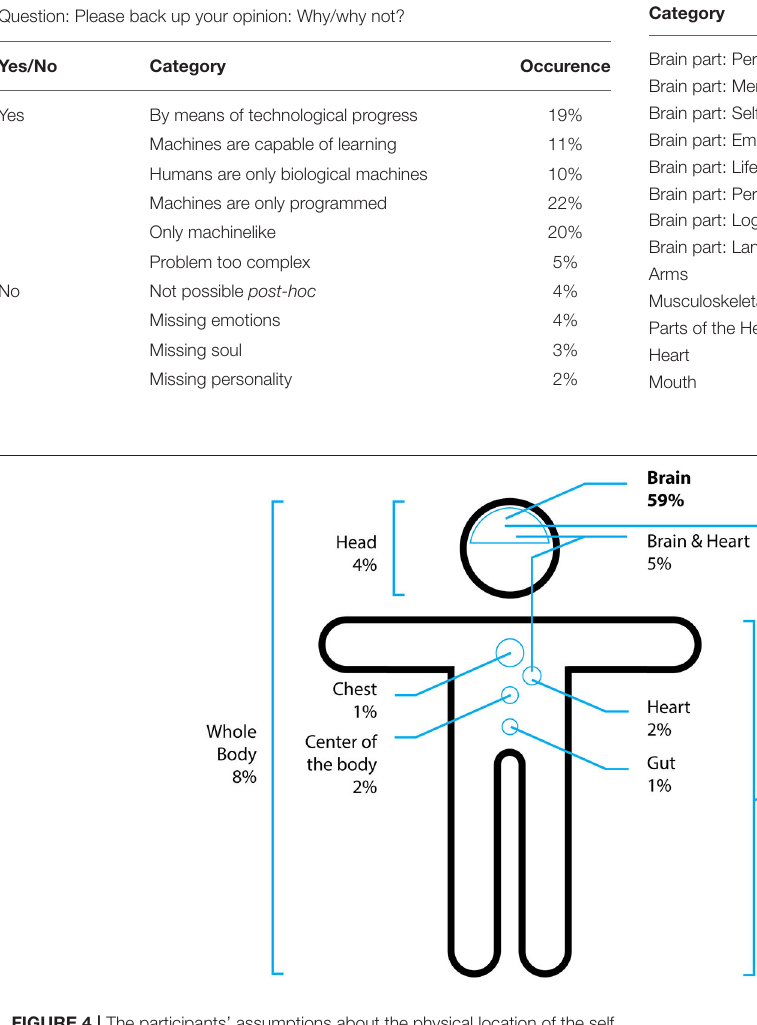
Frontiers in Robotics and AI |